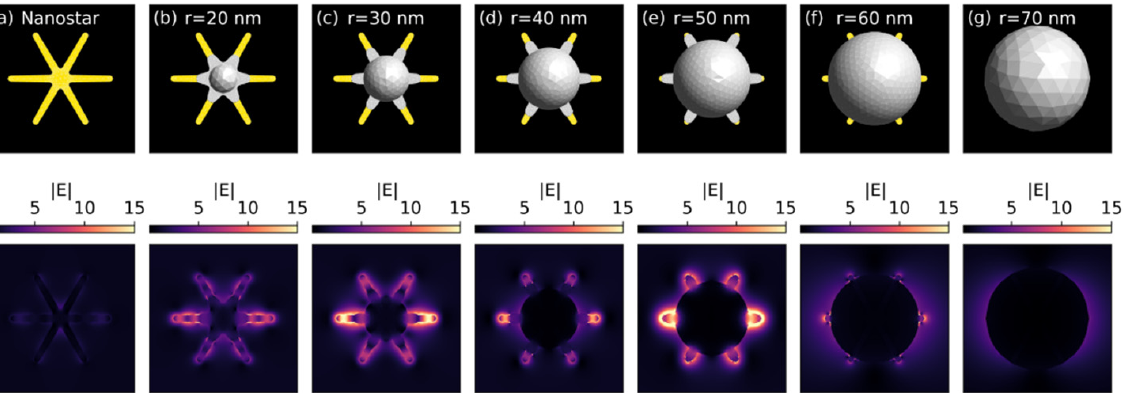
Figure 4. Local field enhancement maps for a pristine GNS and a R shell = 30 nm GNS@Ag. The field is mapped over a square of side 200 nm at the GNS equatorial plane: ( a , e ) Sketch of the modelled structures; ( b , f ) local field map of the main dipolar resonance at λ = 1645 nm and λ = 850 nm; ( c , g ) local field map of the second order resonance at λ = 775 nm and λ = 600 nm; ( d , h ) local field map of the gold core and silver shell resonance at λ = 520 nm and λ = 400 nm.